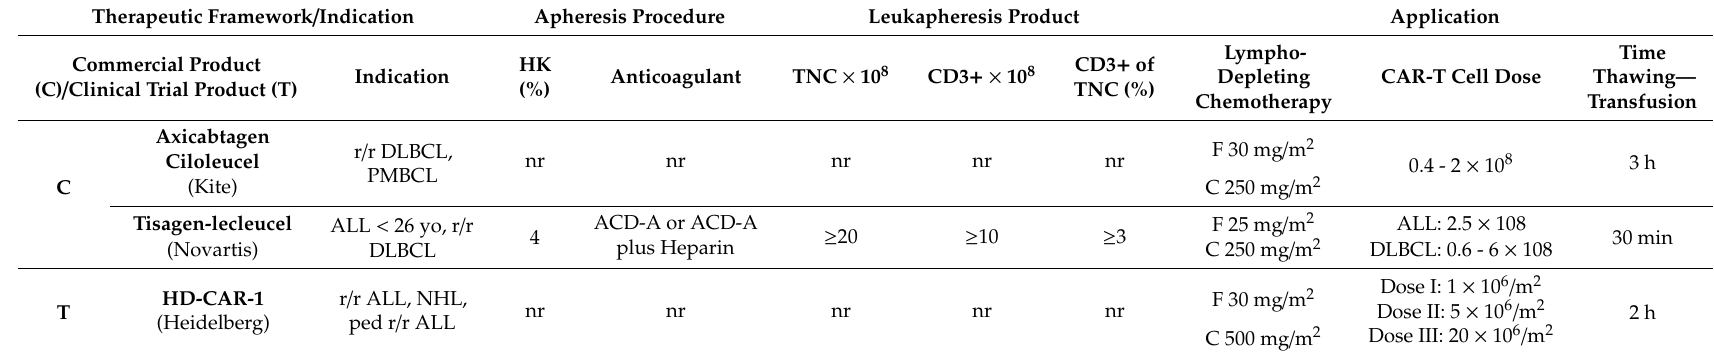
Table 1. Overview of the di ff erent chimeric antigen receptor (CAR) T cell products and requirements by